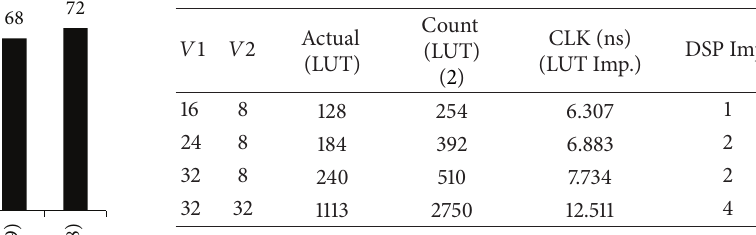
Table 2: Variation of actual (LUT), count (LUT), and DSP imple-